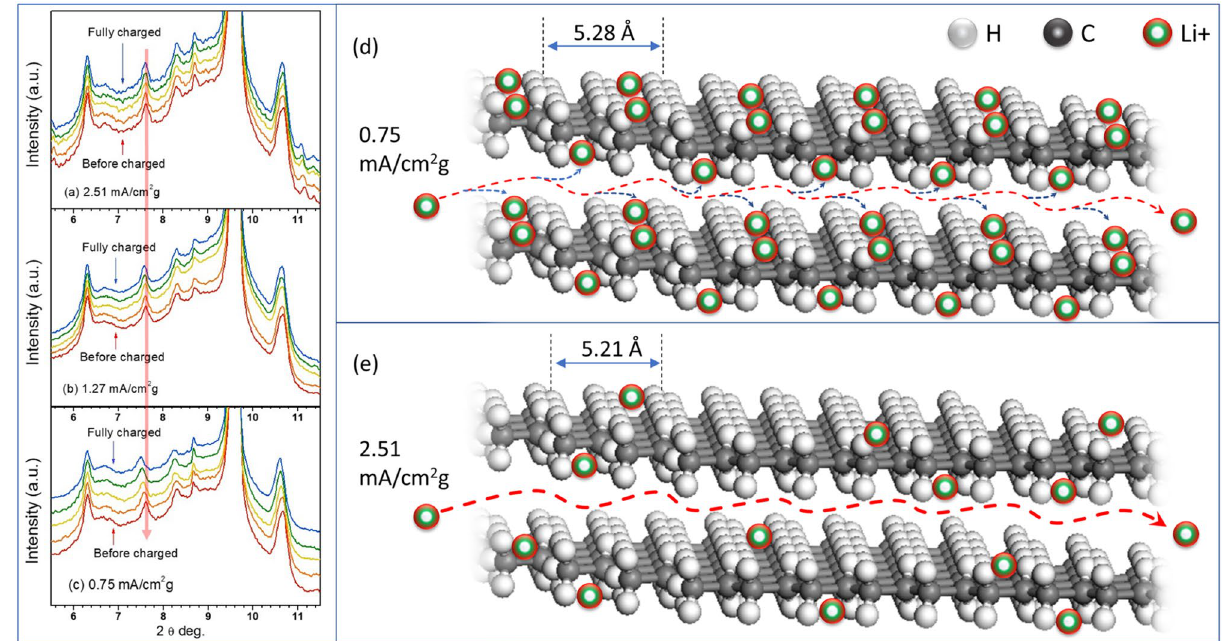
Figure 5. In-situ XRD at different charged states under different charging current density ( a ) 2.51, ( b ) 1.27 and ( c ) 0.75 mA cm −2 g −1 . The frames are vertically shifted for clarity. The schematic representation for the structure evolution of (040) facets in the PP crystal at the charge rate of ( d ) 0.75 mA/cm 2 g and ( e ) 2.51 mA/cm 2 g.